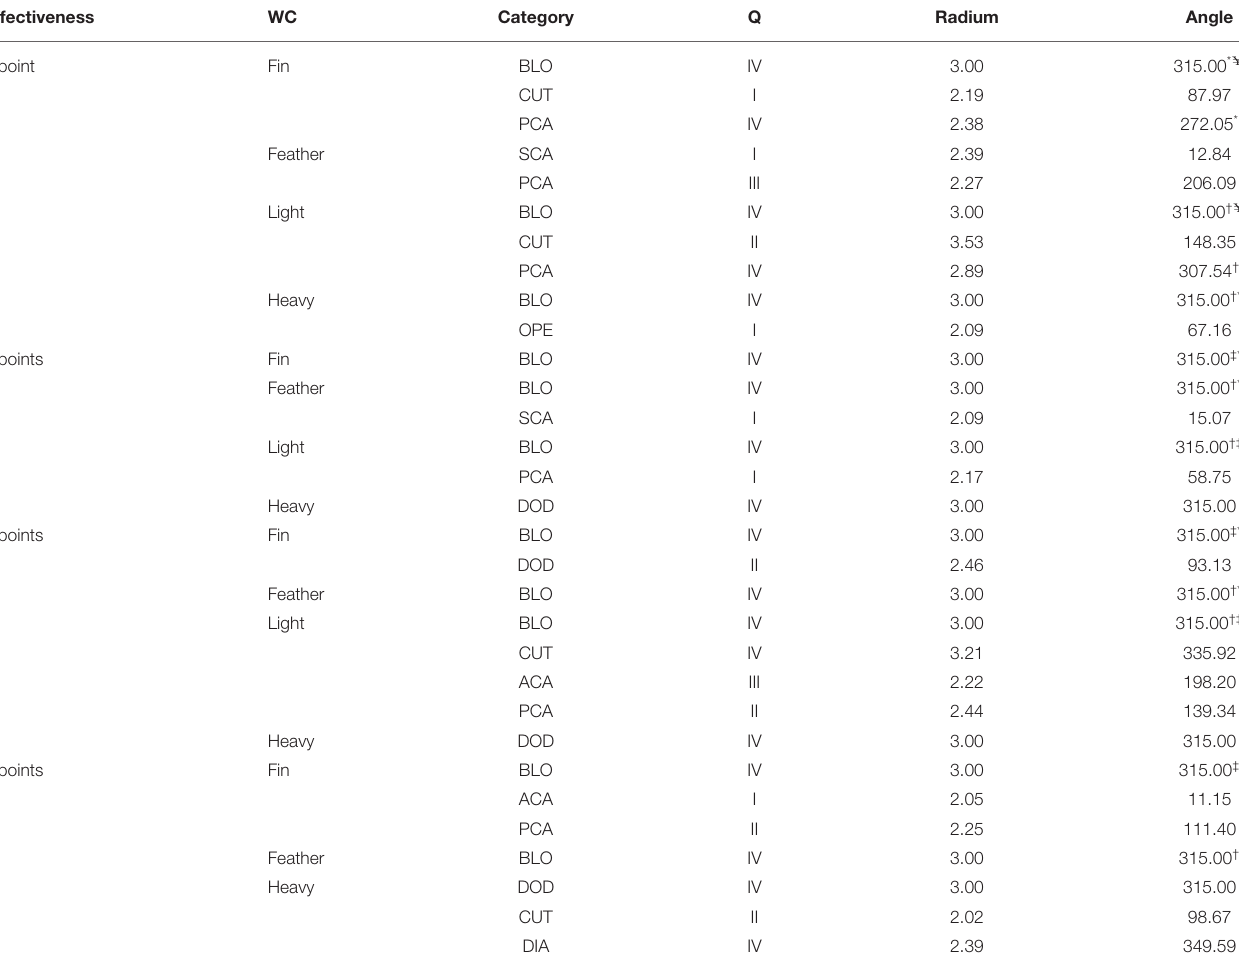
TABLE 5 | Polar coordinate significant patterns for effective actions in males.